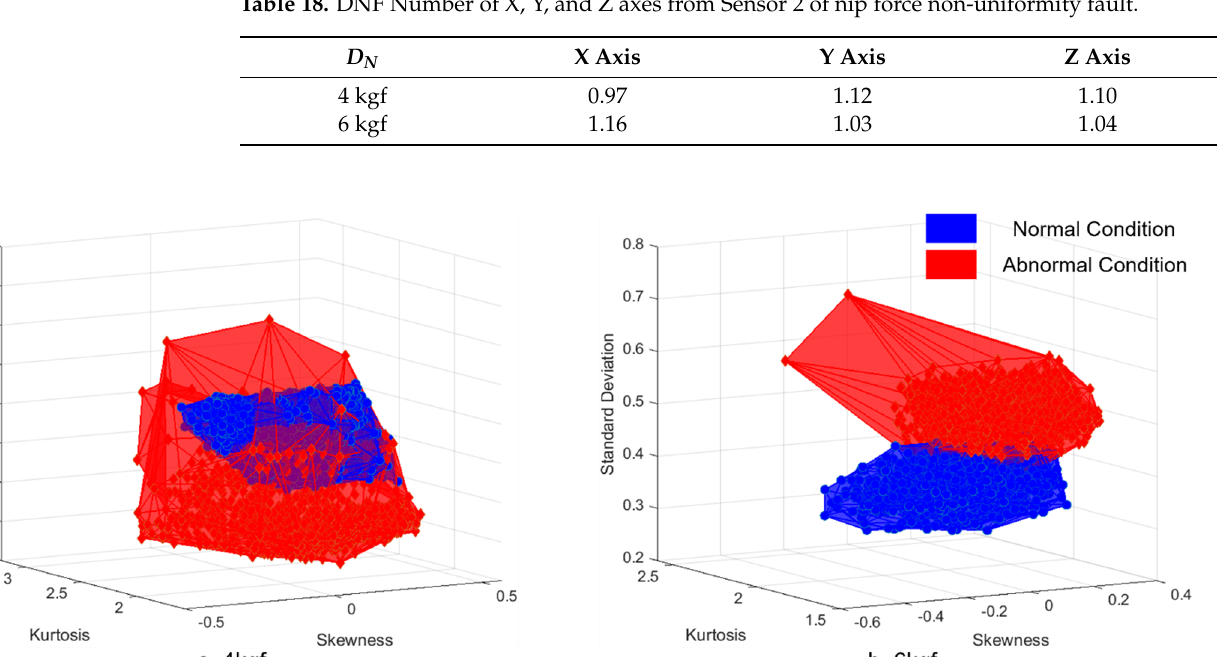
Table 18. DNF Number of X, Y, and Z axes from Sensor 2 of nip force non-uniformity fault.